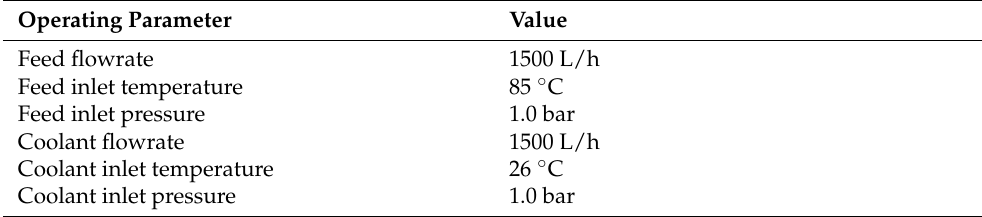
Table 2. Operational parameters of MD